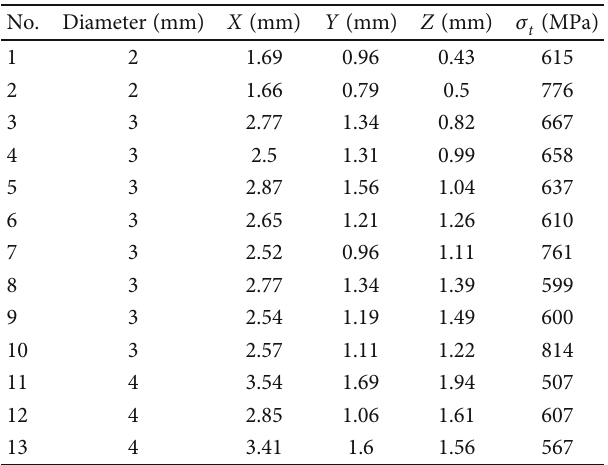
Figure 8: Damage size de fi nition: (a) 3D sketch of the notch; (b) damage width X and damage thickness Y ; (c) damage depth Z . Table 2: HCF limit of notched